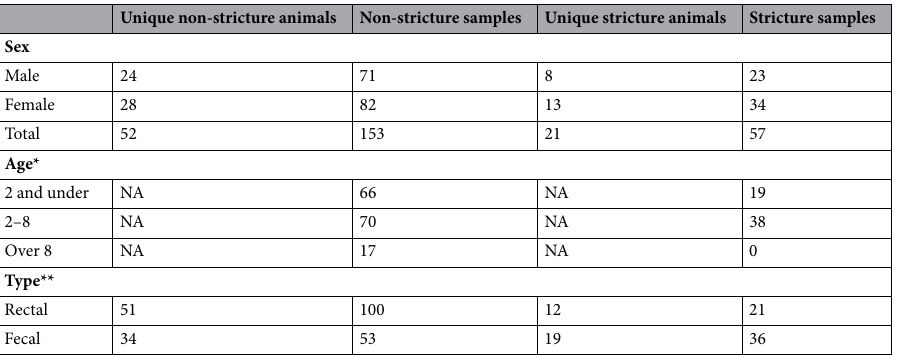
Table 1. Description of microbiome sample demographics of MIT NE . *Number of animals not reported as samples were collected over 2 year period and animals spanned multiple age groups. **Fecal and Rectal Swabs were often collected from the same animal, so number of animals will be higher.